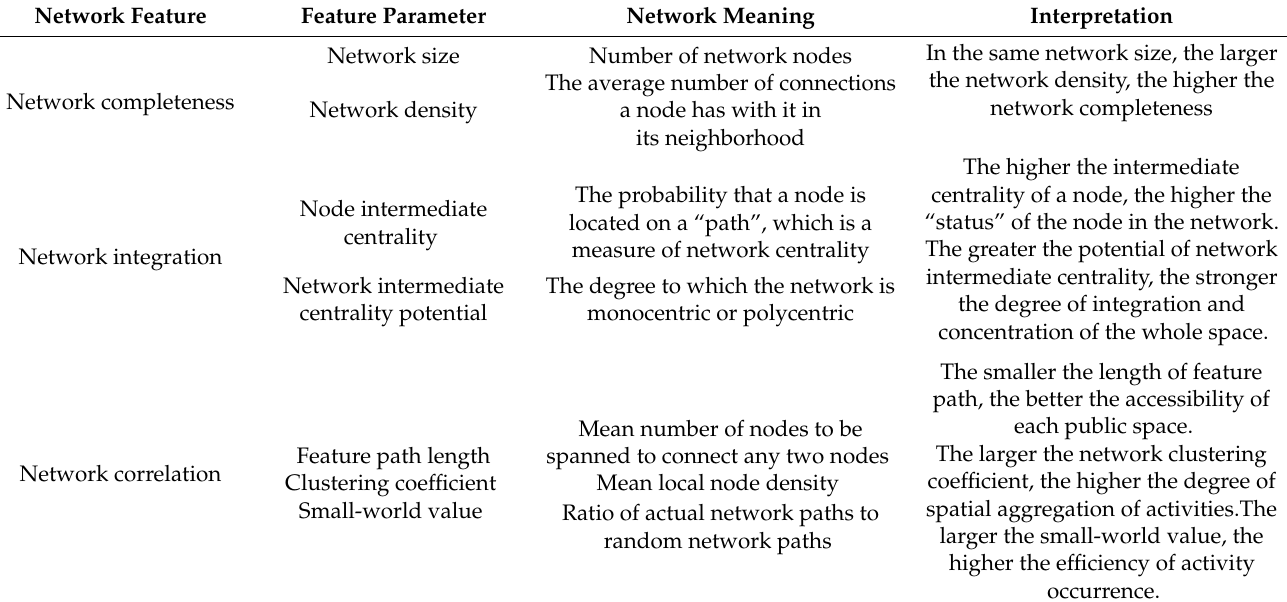
Table 4. Parameters and significance of social network analysis of public space in affordable